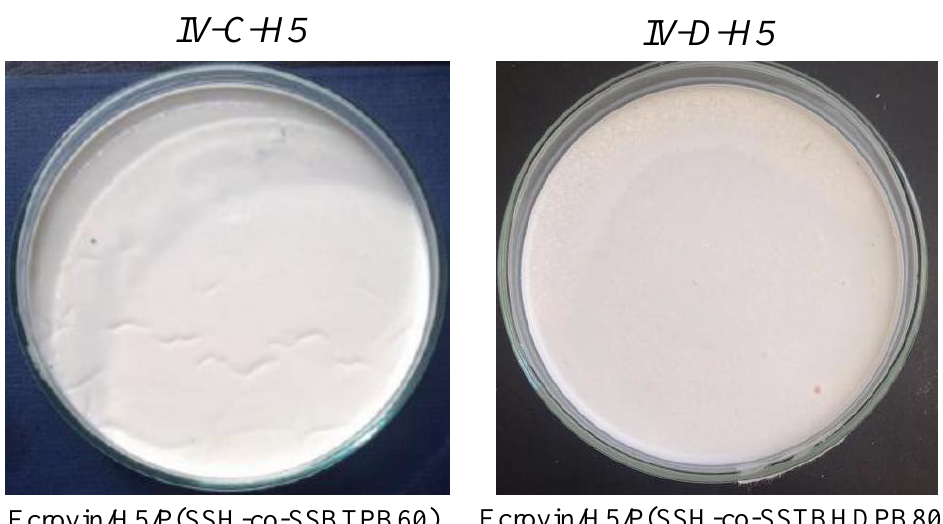
Figure 6. Photographs of the film Ecrovin/H5/P(SSH-co-SSBTPB60) and Ecrovin/H5/P(SSH-co- SSTBHDPB80). SEM images of the Ecrovin/H5/P(SSH-co-SSBTPB60) mixture are also shown in Figure 7.